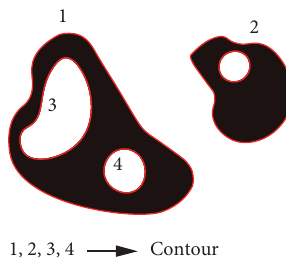
Figure 6: Contour schematic